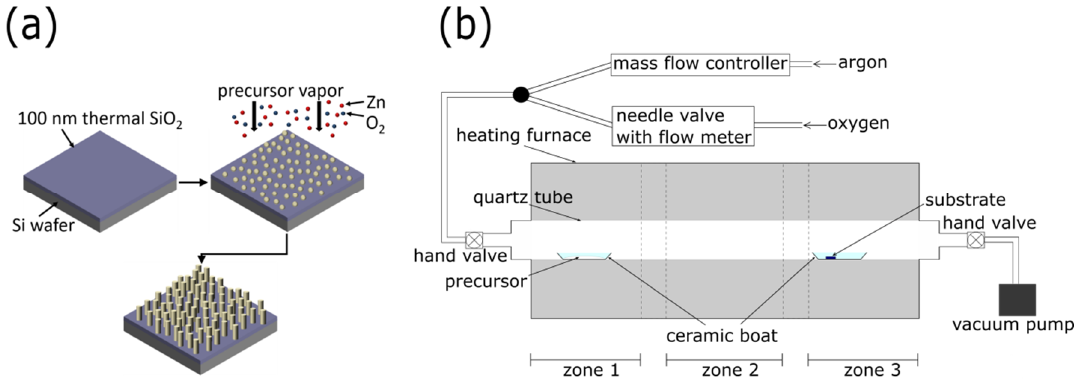
Figure 1. Schematic ( a ) of the vapor-solid growth process and ( b ) of the tube furnace including the connected gas lines, the ceramic boat with the precursor, and the ceramic boat with the